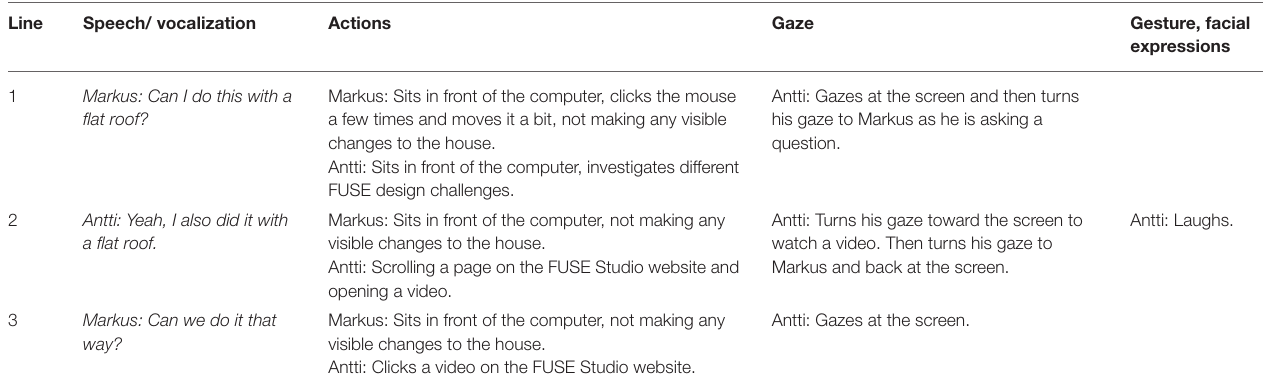
TABLE 7 | Can i do this with a flat